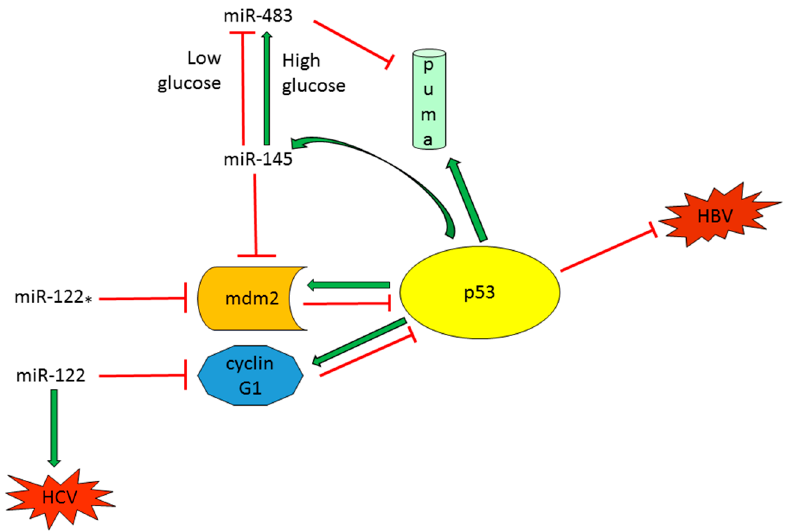
Figure 3. Regulation of p53 protein by tumor suppressor miRNAs. Green arrows: Induction of gene expression or protein activation. Red lines: Inhibition of gene expression or block protein activity.